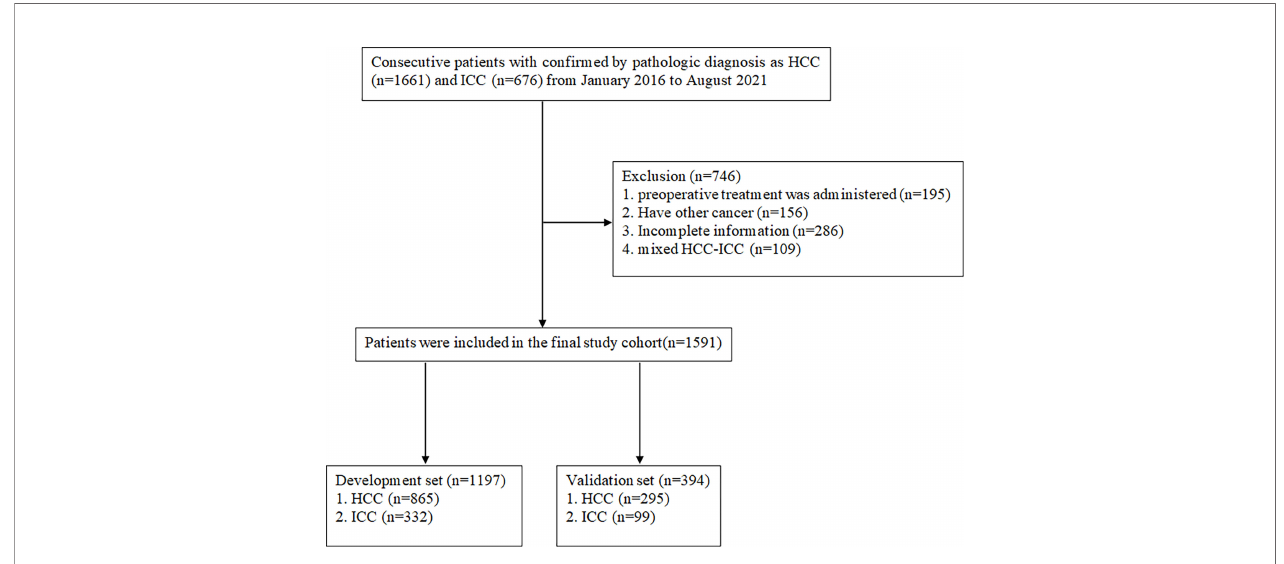
FIGURE 1 | Flowchart detailing the patient selection process and exclusion